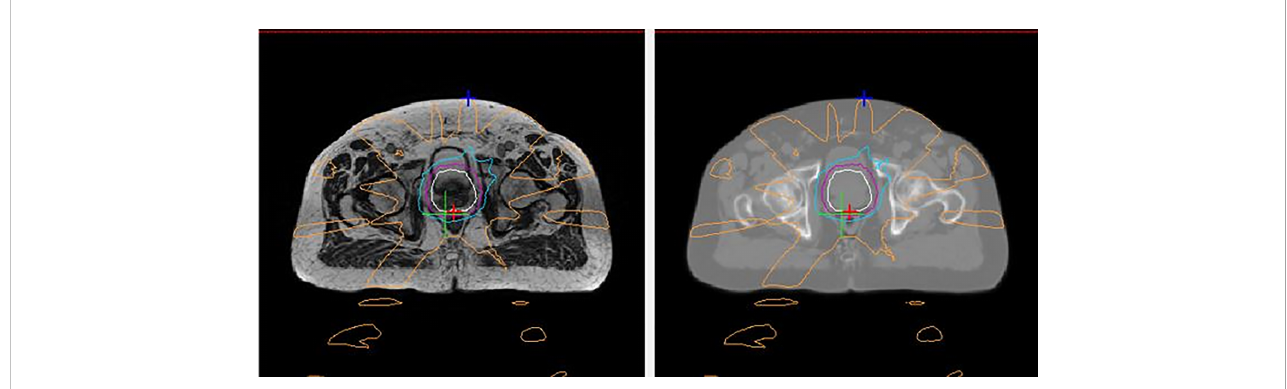
FIGURE 6 An example of a generated synthetic-CT (sCT) for prostate radiotherapy. The left panel shows an axial MR image acquired with a MRI-Linac during a MRI simulation. The right panel shows the corresponding sCT generated based on that MRI image by converting MR intensities into Houns fi eld